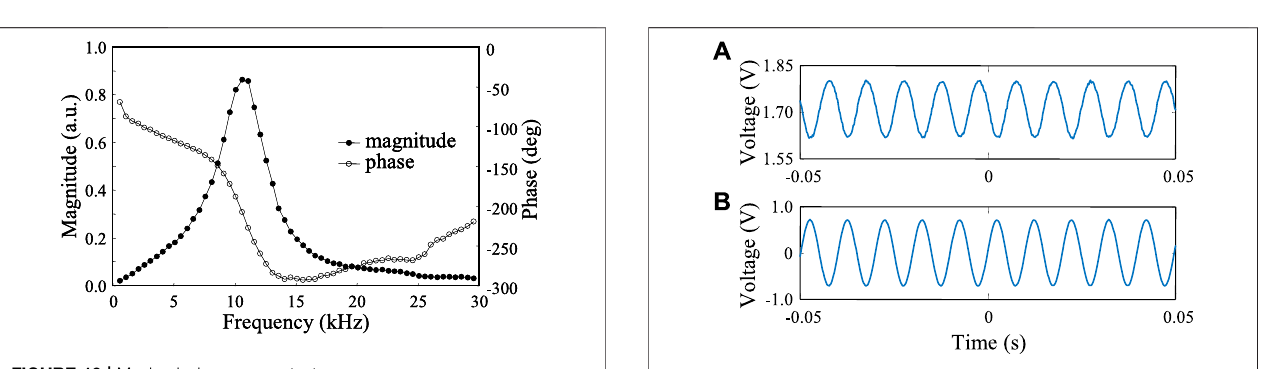
FIGURE 10 | Mechanical resonance test.